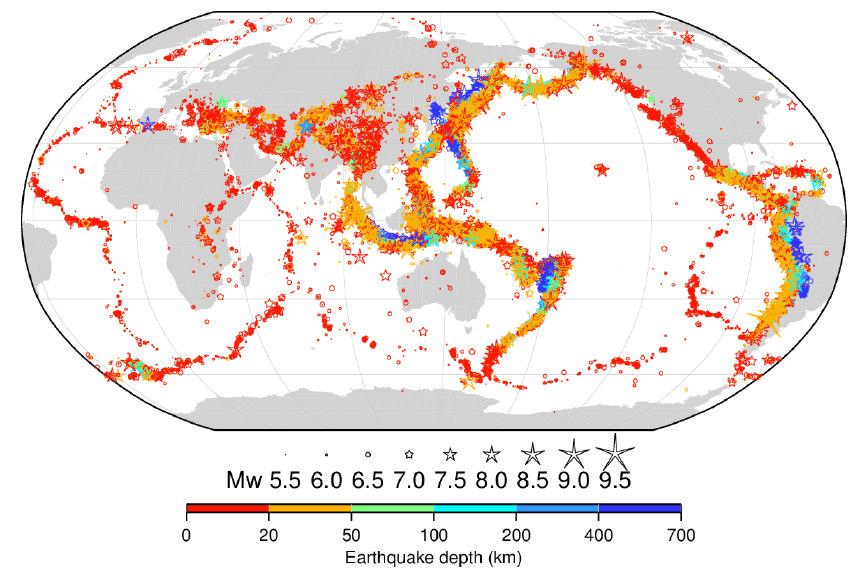
Figure 24. Map showing the earthquakes listed in V5 of the ISC-GEM Catalogue (more than 28000 earthquakes, see Fig. 25). The symbols are plotted according to Agnew (2014) and colour-coded according to the ISC-GEM depth. The earthquakes shown are from the Main catalogue plus those earthquakes in the Supplementary catalogue that have reliable magnitude but poor location (i.e. magnitude quality flag not equal to D and location/depth quality flag equal to